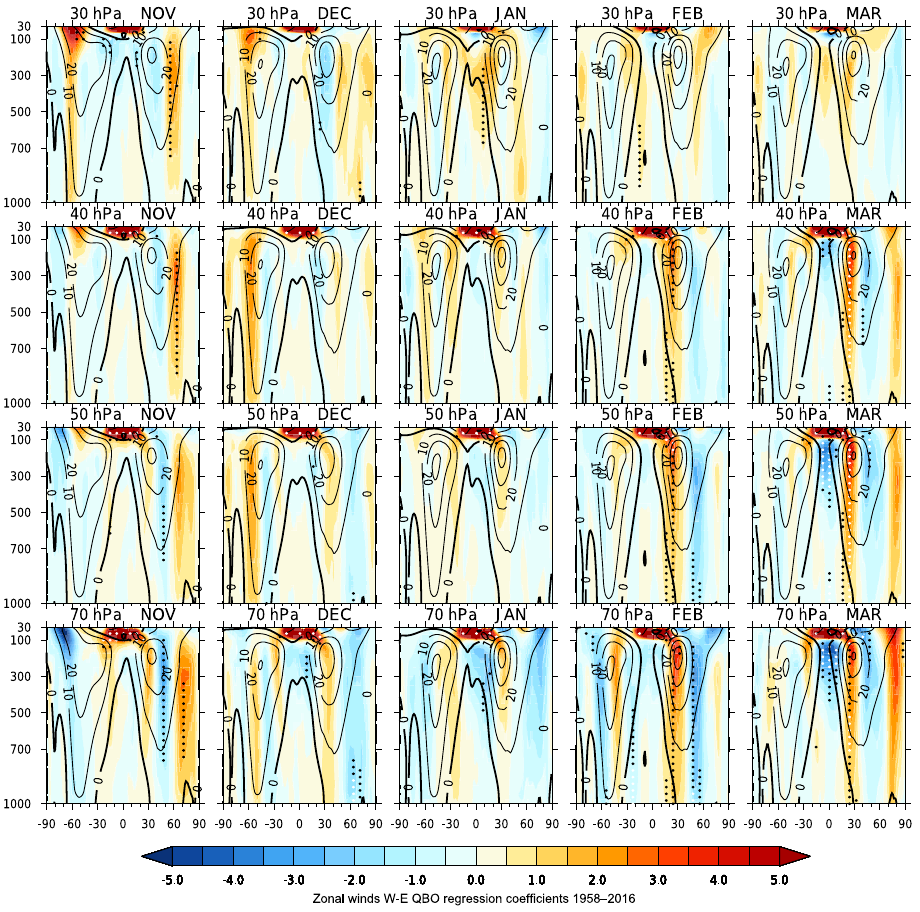
Figure 6. As Fig. 4 but using a linear height scale between 30 and 1000hPa to emphasize the tropospheric response. Note that the colour scale has been amended